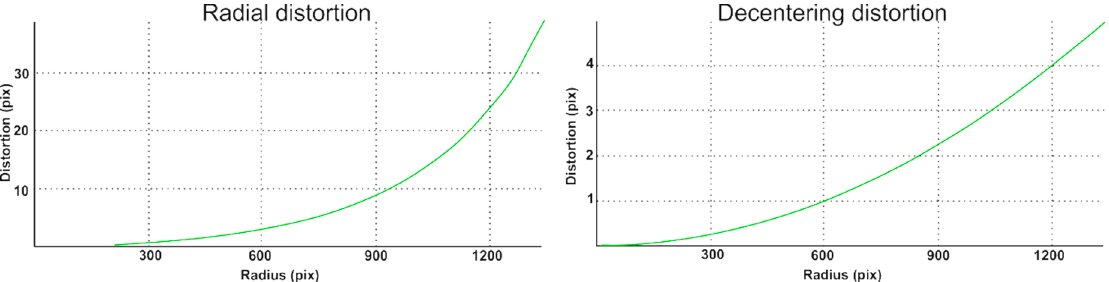
Figure 7. The graph with the distortion function of the cameras.